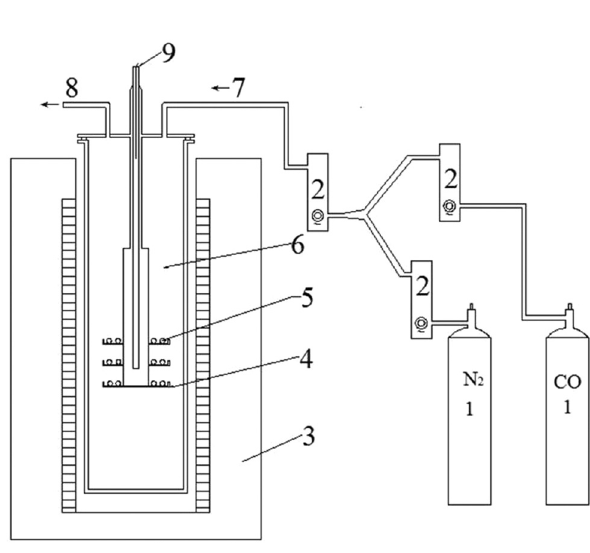
Figure 1: Schematic diagram of the reduction swelling test device. ( 1 ) Gas bottle; ( 2 ) flow meter; ( 3 ) reduction furnace; ( 4 ) test vessel; ( 5 ) briquettes; ( 6 ) reduction tube; ( 7 ) gas inlet; ( 8 ) gas outlet; ( 9 )